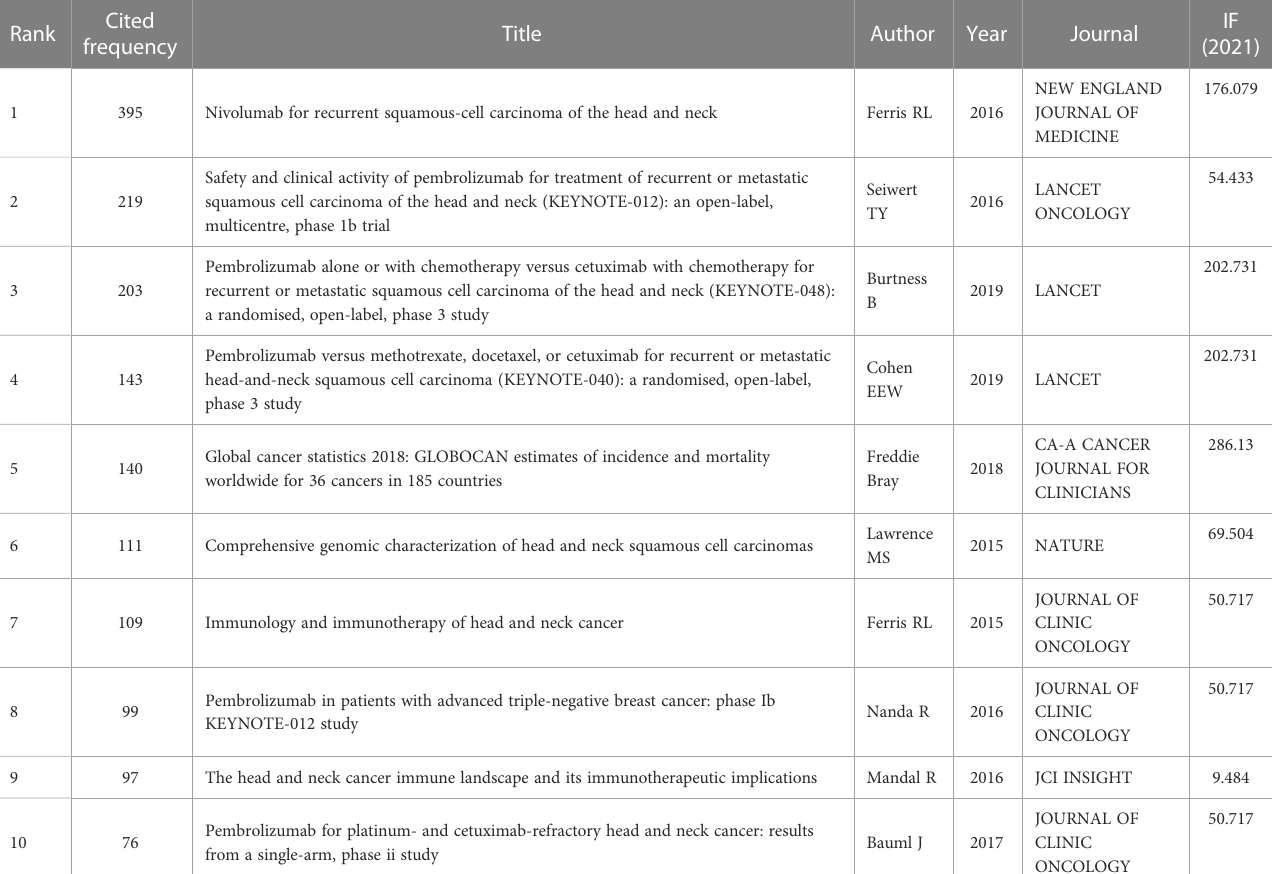
TABLE 5 Top 10 Most Cited References in Immunotherapy for HNSCC.